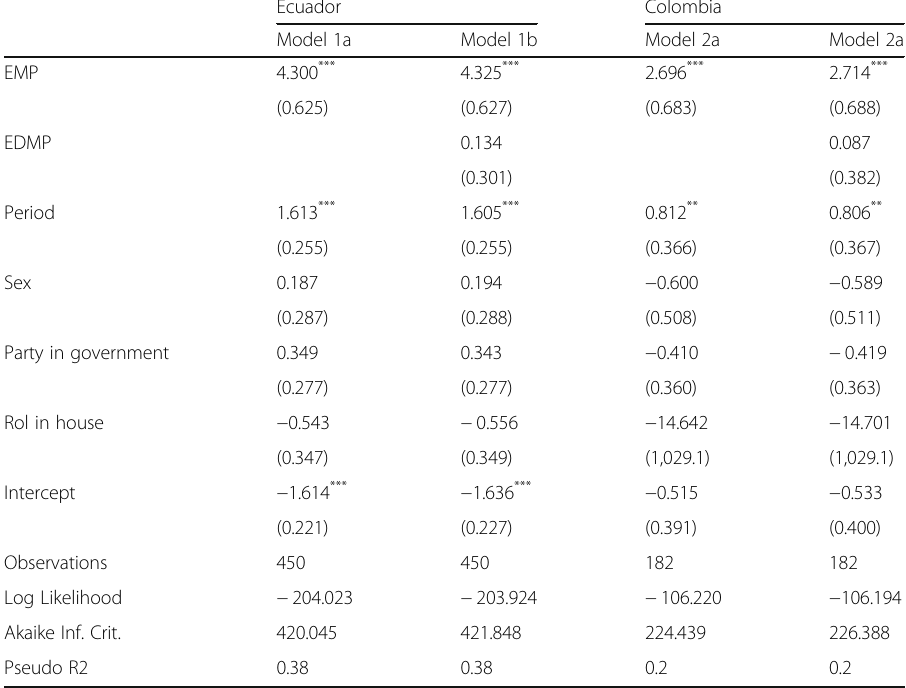
Table 6 Logistic regression for the classification of speeches: Non-emigrant related speeches (0). emigrant-related speeches